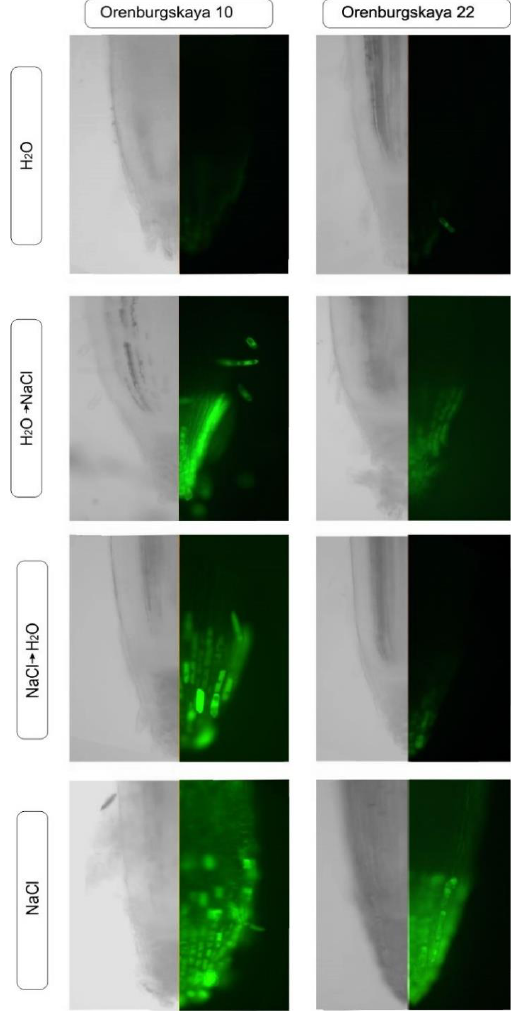
Figure 8. Distribution of reactive oxygen species (ROS) + and ROS - cells in the zones of 10-day-old